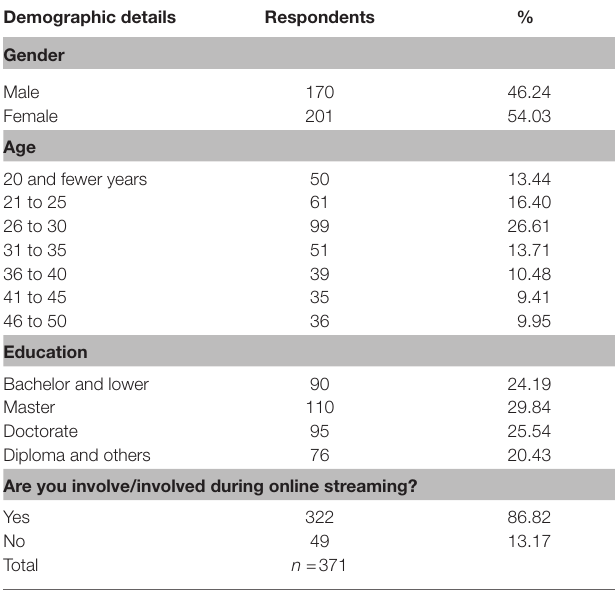
TABLE 1 | Demographic details of